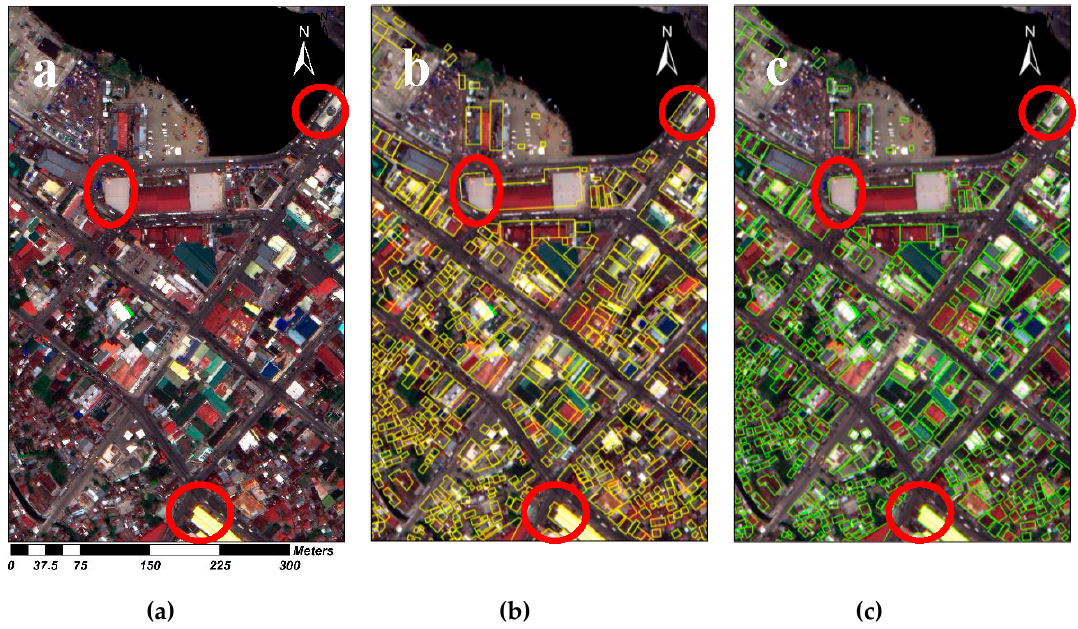
Figure 2. Example of the co-registration of the OpenStreetMap (OSM) building map and satellite images for Tacloban city, the Philippines. ( a ) Pre-disaster satellite image, ( b ) original OSM building map, and ( c ) modified OSM building map. The areas denoted by red boundaries show the effect of the refinements on the OSM map data.